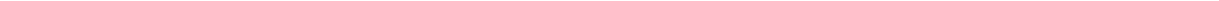
Fig. 2 Lefty1 expression begins in cells positive for Nodal-Foxh1 signaling. a Expression of Nodal signaling components in mouse embryos at E3.5 and E4.5. Expression of Cripto(Tomato) and Smad2(Venus) BAC transgenes as well as that of GATA6 were monitored by immuno fl uorescence staining, whereas that of a Foxh1-Ires-lacZ transgene was monitored by X-gal staining. Scale bars, 50 μ m. b Embryos harboring A 7 -Venus were examined for Venus and GATA6 immuno fl uorescence at E3.5 and E4.5 (top two panels). Note that Venus is expressed in a GATA6 – cell at E3.5 and in GATA6 + cells at E4.5. An E4.5 embryo harboring A 7 -Venus and a Lefty1(Cherry) BAC transgene was examined for Venus and Cherry immune fl uorescence (third panel). Arrowheads indicate two Lefty1 + cells that are also positive for Venus. An E6.0 embryo harboring A 7 -Venus was subjected to immuno fl uorescence staining for Venus, Lefty, and Oct3/4 (bottom panel). Arrowheads indicate Cherry in magenta, Venus in green and Lefty1 in light blue. Boxed regions are shown at higher magni fi cation in the images immediately below. Scale bars, 50 μ m. c An E3.2 embryo harboring both Lefty1(Cherry) and A 7 -Venus transgenes was cultured for 9 h. Fluorescence of Venus and Cherry was examined at the indicated times. A single cell positive for Venus was detected at 8.25 h (arrowhead). This cell had being positive for Cherry at 9 h. d An E3.2 embryo harboring both Lefty1(Cherry) and A 7 -Venus transgenes was cultured for 23.15 h in the presence of 10 µ M SB431542 and monitored for Venus and Cherry fl uorescence. Note that Venus or Cherry fl uorescence is not apparent at 23.15